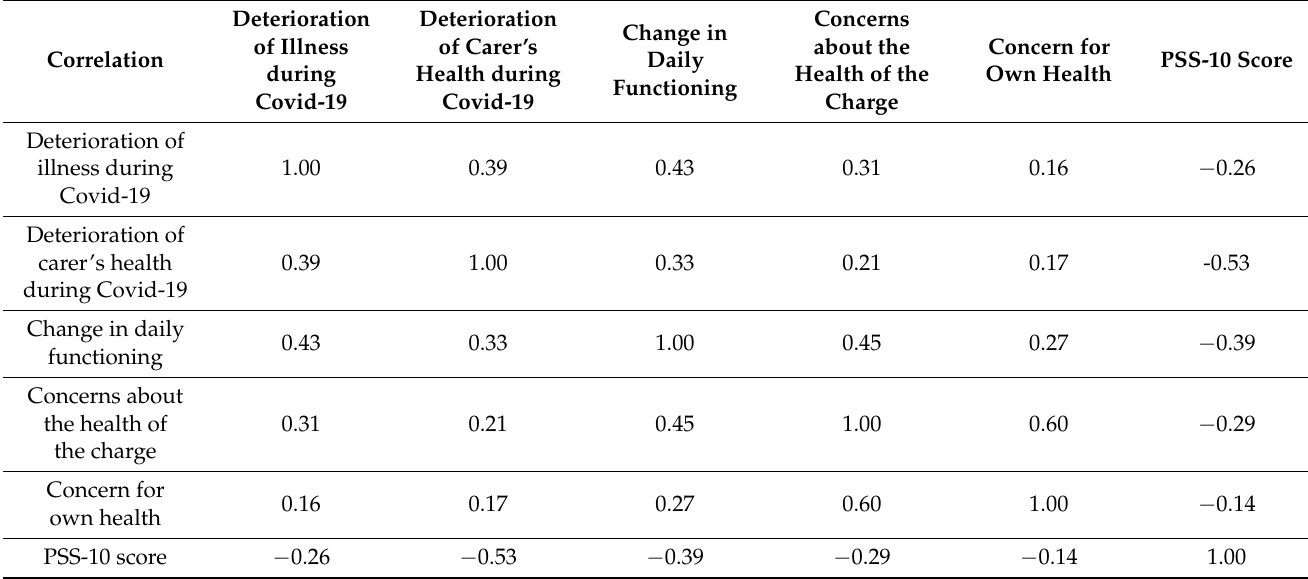
Table 4. Coefficients of correlation of the PSS-10 score with deterioration of illness during Covid-19, caregiver’s health, change in daily functioning, and concerns about the health of the charge with AD in the study group.